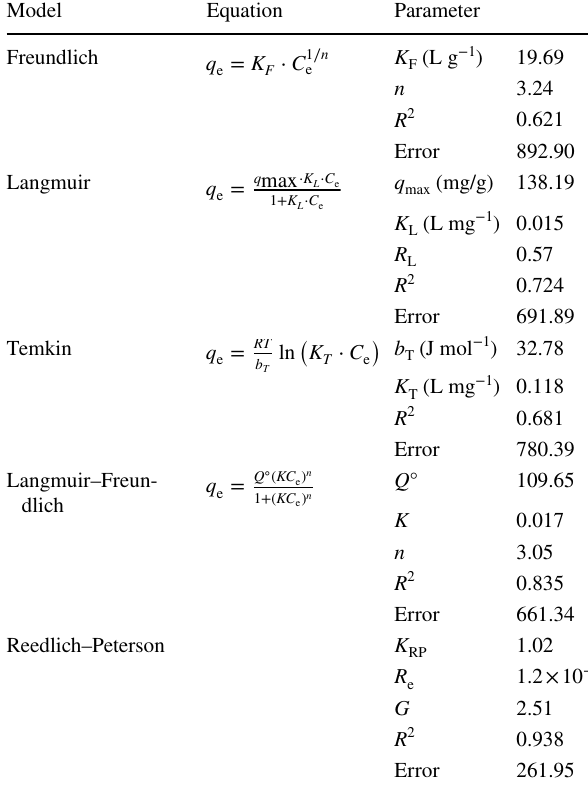
Table 2 Kinetics model parameters for the adsorption of Pb 2+ on WM-Fe 3 O 4 Model